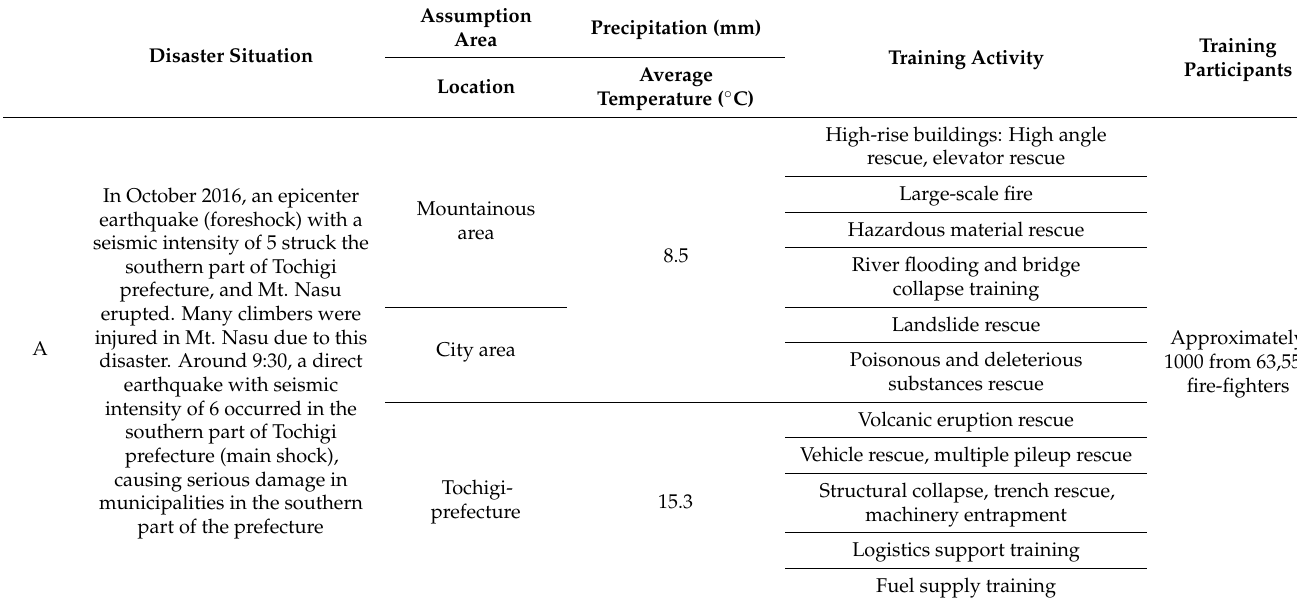
Table A1. Overview of Disaster simulation training (Long-term training conducted with assumptions that are close to real disasters and whose contents are not informed to participating members in advance, which is considered to be the most similar to a real